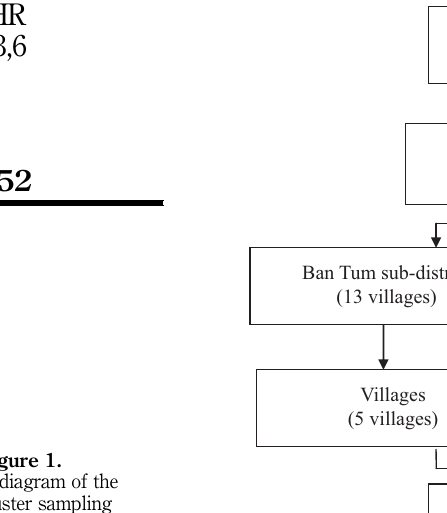
Figure 1. A diagram of